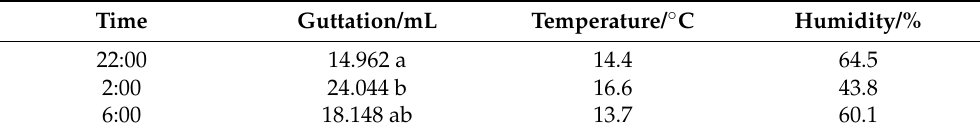
Table 1. Changes the average of guttation volume with temperature and